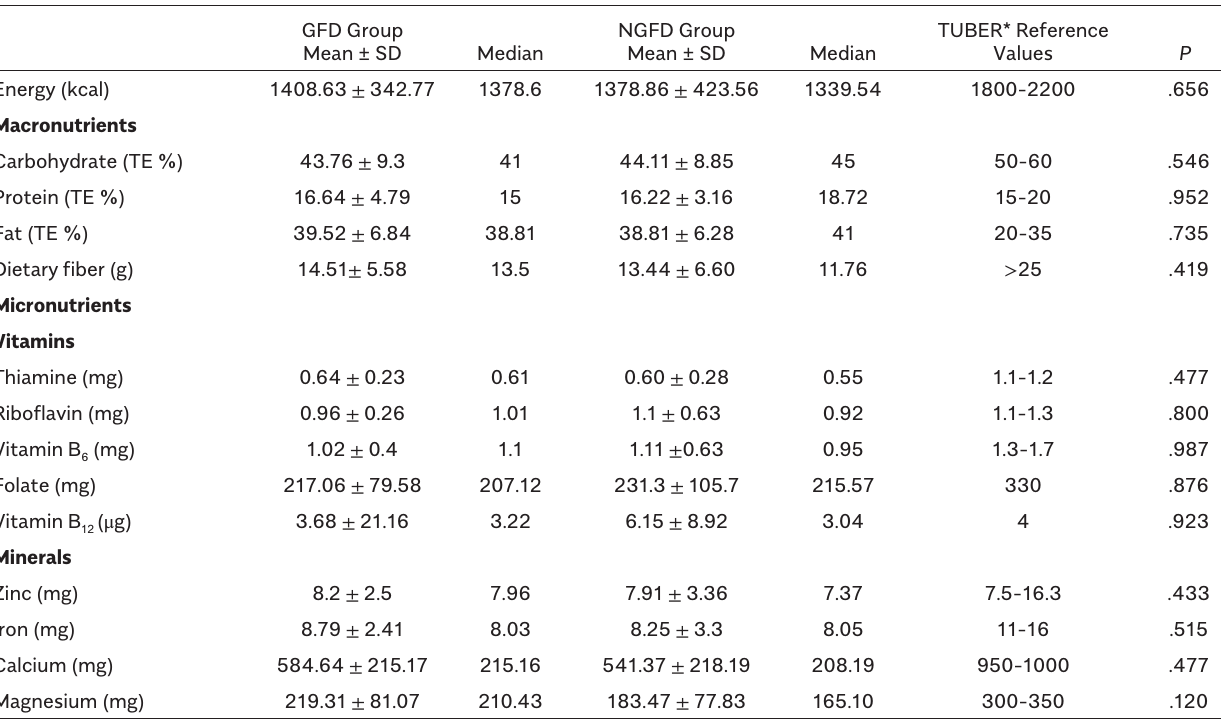
Table 4. Daily Energy and Nutrient Intake of Groups